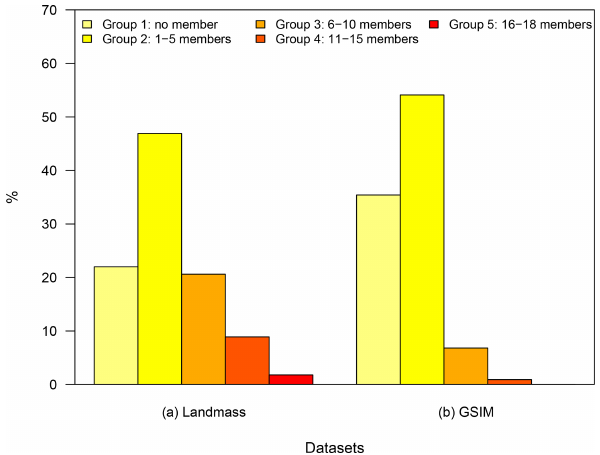
Figure 6. Percentage of grid cells (“Landmass”) grouped by the number of simulations projecting a significant increasing trend un- der the RCP6.0 scenario, and the percentage of streamflow stations (“GSIM”) assigned into each group. The range of possible simula- tions is from 0 to 18 and binned into five groups (Group 1: no mem- bers, Group 2: from 1 to 5 members, Group 3: from 6 to 10 mem- bers, Group 4: from 11 to 15 members and Group 5: from 16 to 18 members). To identify which group a specific station belongs to, the geographical coordinates of that station was superimposed on top of the global “flood-risk”